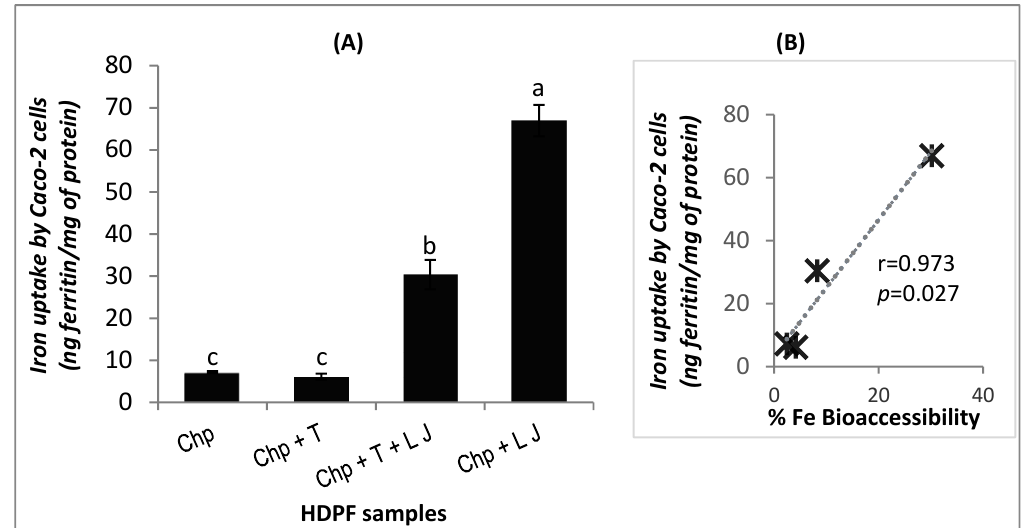
Figure 3. ( A ) Iron uptake (expressed as ng of ferritin/mg of total protein content in Caco-2 cells) from four HDPF samples (HDPF VIII, I, II, and IV ). ( B ) Pearson’s correlation test between iron bioaccessibility (%) and iron uptake (ng ferritin/mg of protein) from the four HDPF samples. (HDPF: hummus with different processing and formulation). Results are expressed as a mean ± IC ( n = 7; IC 95%). Bars not sharing a letter are significantly different ( p < 0.05), according to the one-way ANOVA test followed by Tukey’s post-hoc test at 95% confidence. Chp: chickpea, T: tahini, LJ: lemon juice, G: garlic. Table